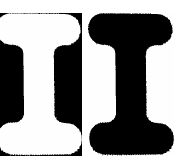
Figure 4. Inverse images with PCC = − 1.